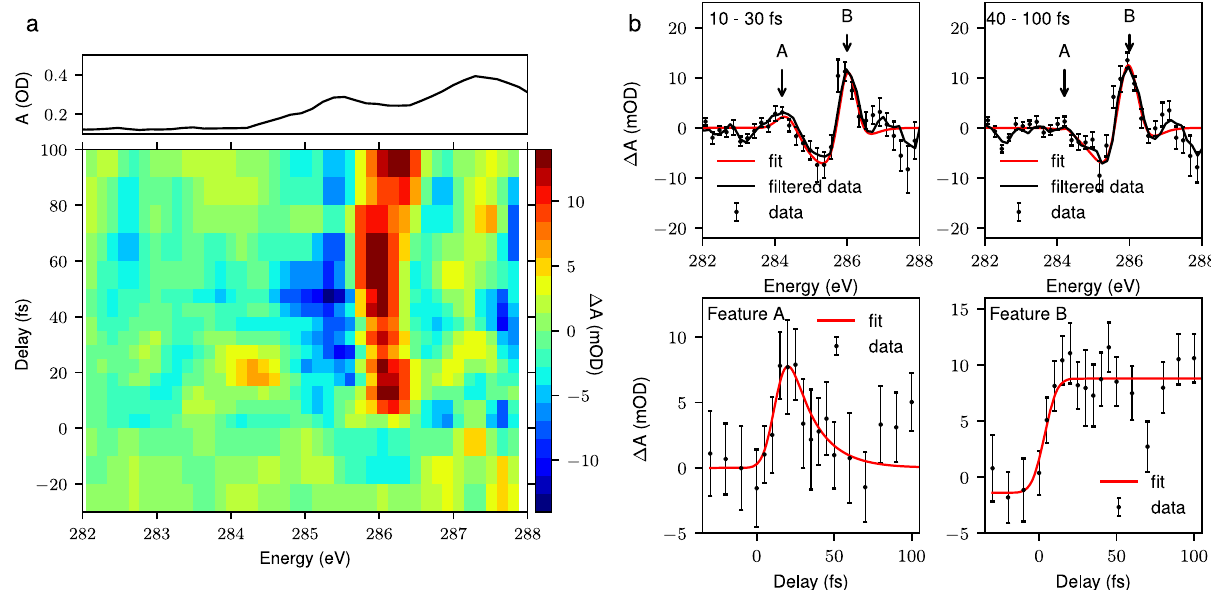
Fig. 2 Experimental time-resolved X-ray absorption spectrum. a TR-XAS spectrum of P3HT from − 30 fs to 100 fs in the vicinity of the carbon K-edge. A static absorption spectrum of the sample is plotted above, on the same energetic axis. b The average TR-XAS spectrum across 10 to 30 fs and 40 to 100 fs (top row). The black lines show the measured spectrum and the red line shows the three component Gaussian fi t to the data used to determine the spectral positions of the features discussed in the text. The bottom row shows the time evolution of the two positive differential absorption features A and B, discussed in the main text. The red lines show an exponential decay and step function fi t to the temporal traces for feature A and B respectively. The error bars correspond to ±1 standard error. Further details can be found in the Methods